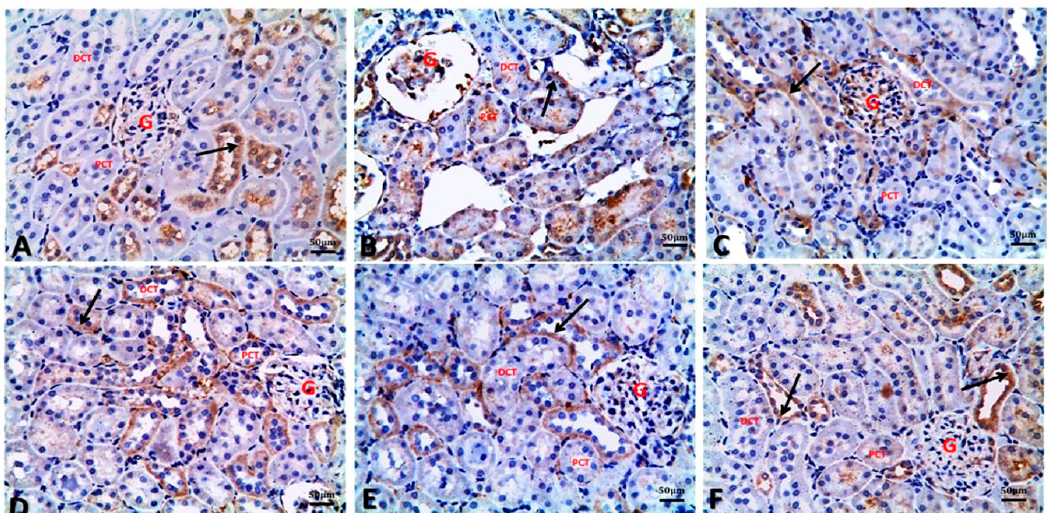
Figure 5. Representative photomicrographs of immuno-histochemical localization of Bcl-2 in kidney sections of different groups (Bcl-2 IHC, bar = 50 µm). ( A ) Control group showing cytoplasmic Bcl-2 immune-staining in the renal tubular epithelium. ( B ) BM group showing marked decrease in Bcl-2 immune-expressions in the renal tubular epithelium. ( C ) AO/0.5 and ( D ) AO/1 showing cytoplasmic Bcl-2 immune-staining as control group. ( E ) BM+AO/0.5 showing marked increase in the cytoplasmic immune-staining of Bcl-2 within the renal tubules. ( F ) : BM+AO/1 showing marked increase in the Biology 2020 , 9 , x FOR PEER REVIEW cytoplasmic Bcl-2 immune-staining within the renal tubular epithelium.